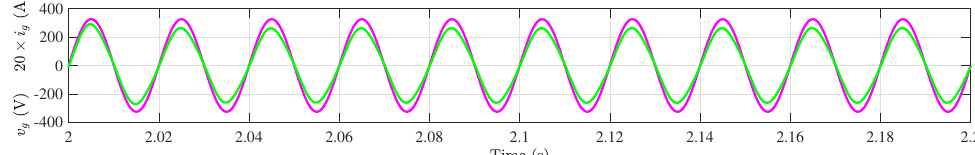
Figure 4. Time-domain waveforms of the sampled grid voltage v g and sampled grid current i g for S = 1000 W/m 2 in steady-state operation. V M = 3.2